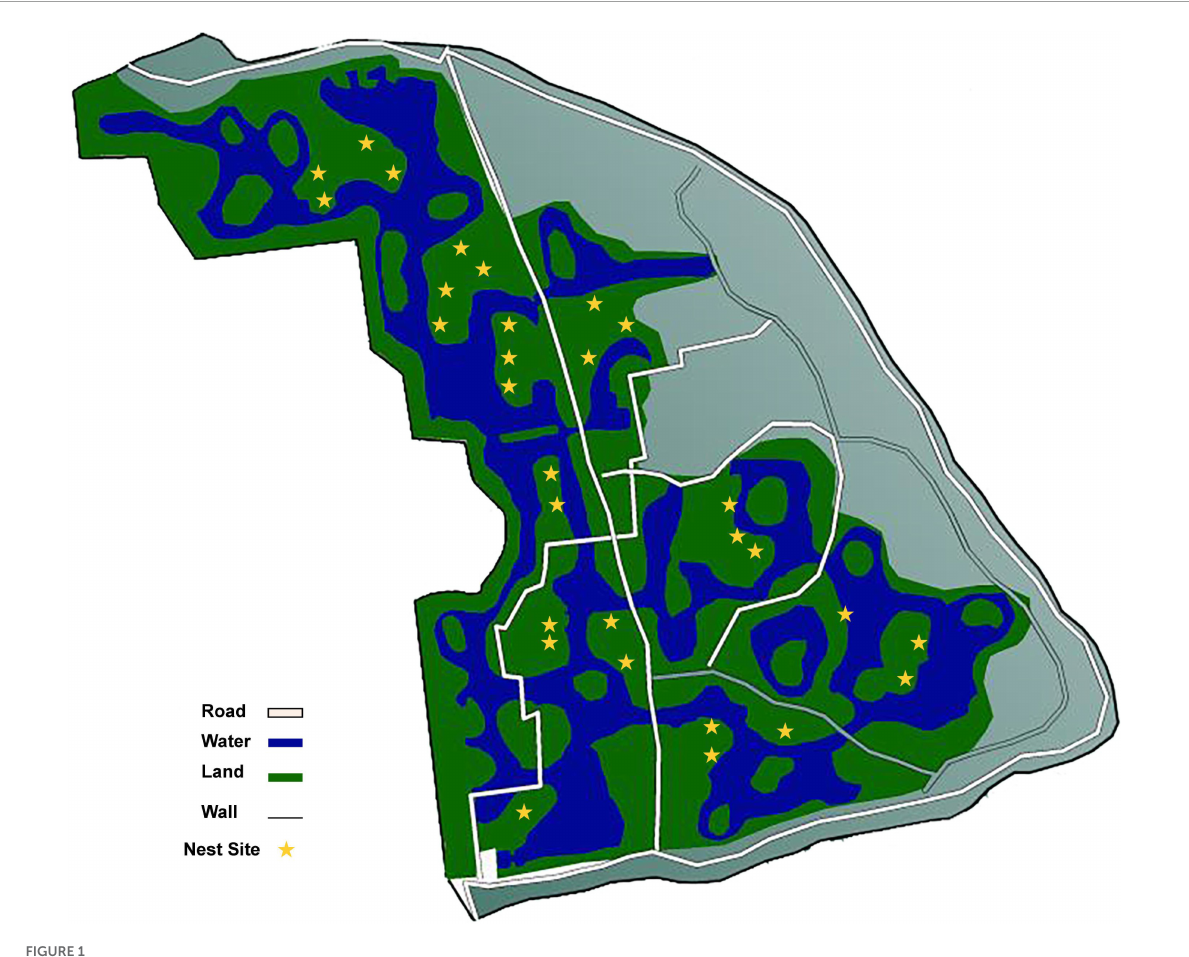
FIGURE1 The sampling sites in this